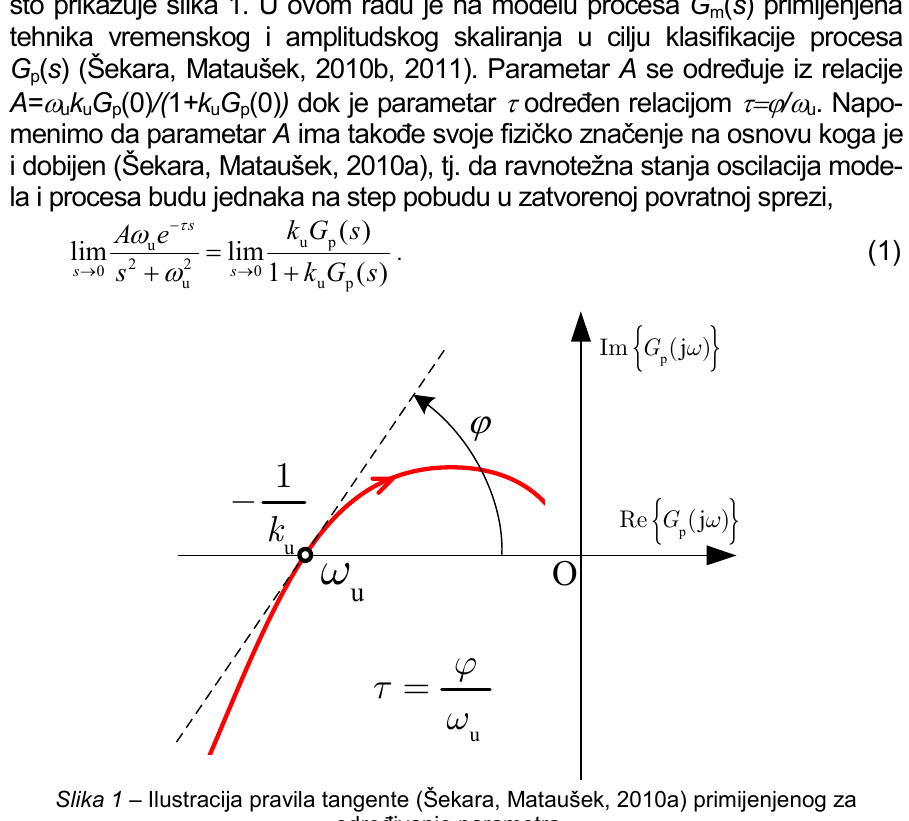
Figure 1 – Illustration of tangent rule (Šekara, Mataušek, 2010a) used to determine parameter